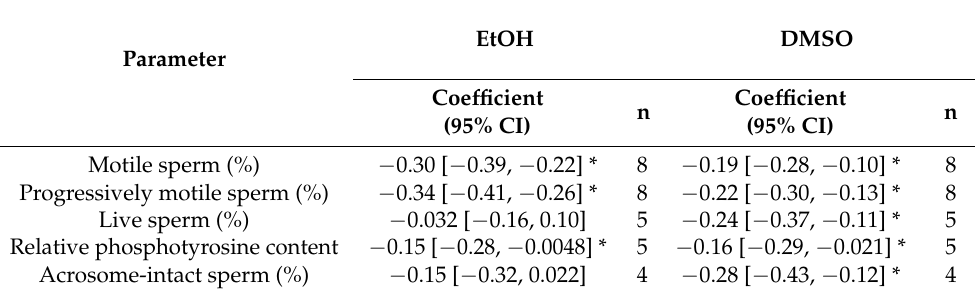
Table 2. Influence of ethanol (EtOH) and dimethyl sulfoxide (DMSO) on sperm parameters, shown through fitting linear mixed models. The fixed effect coefficient for the concentration of solvents is shown with 95% confidence intervals and the number of donors, n.